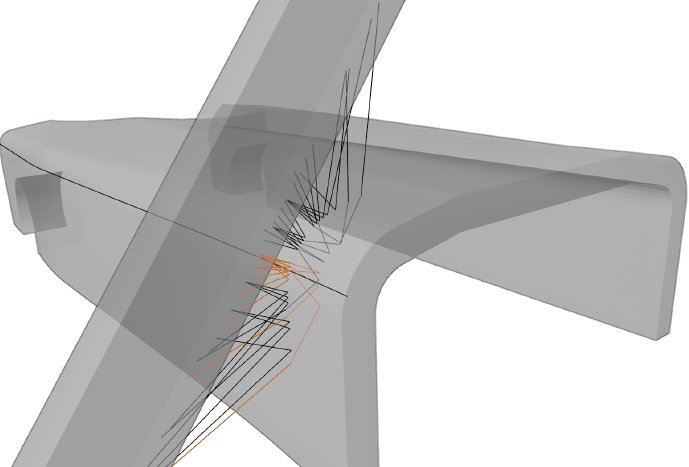
Figure 4. Visualization of reflected rays on the geometry of a complex beam. The PA sensor is positioned at a working distance to a streamline that follows the edge of the part. To reduce clutter in the visualization, the depicted phased array sensor consists of only 21 transducers. Only 5 co- planar rays are emitted by each transducer. The rays highlighted in orange are emitted by the same transducer near the center of the ultrasound sensor. Some rays are reflected at the front wall and some at the back wall of the